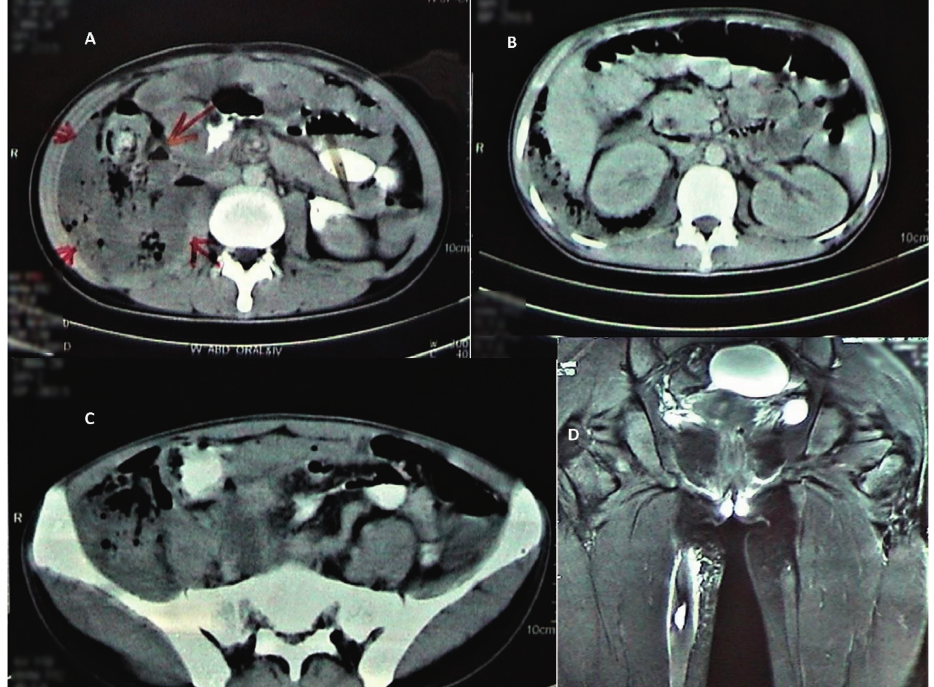
Figure 1: CT scan abdomen with oral contrast showed a large retroperitoneal collection with multiple air lucencies displacing ascending colon and caecum medially. (a) Discontinuity in the posterior wall of ascending colon with a large collection having internal air lucencies, (b) collection with internal air lucencies seen in the right pararenal and posterior perihepatic soft tissue planes, (c) retroperitoneal collection seen tracking into the right iliac fossa, and (d) elongated collection and surrounding soft tissue oedema seen along hamstring muscles of the right thigh.